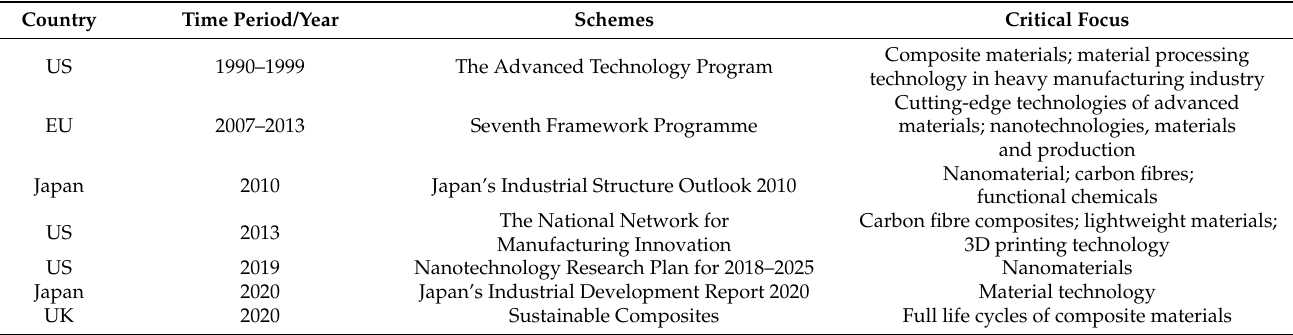
Table 2. International representative schemes of materials